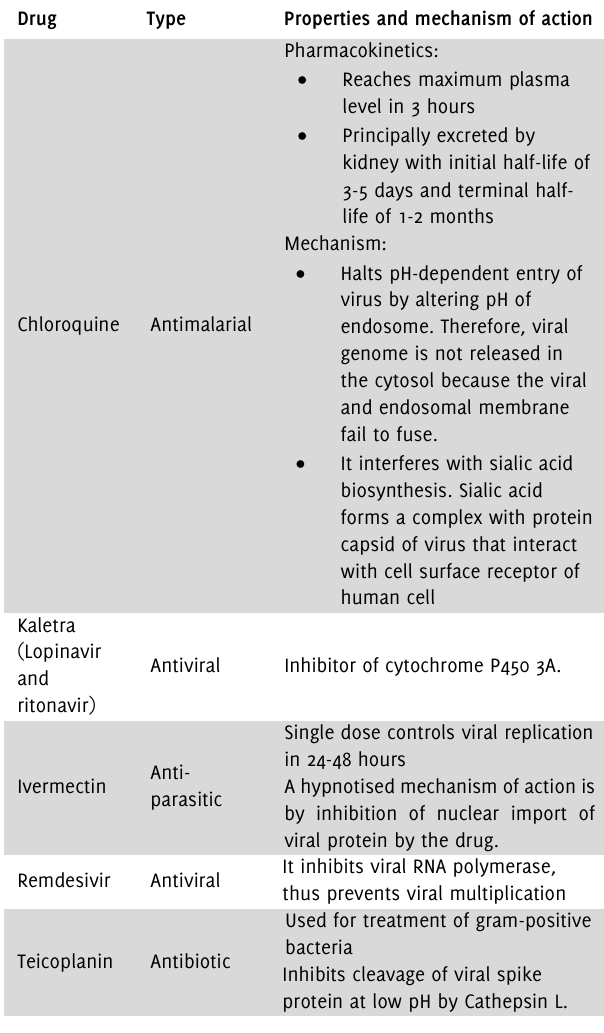
Table 2. A list of recommended drugs with their properties and possible mechanism of